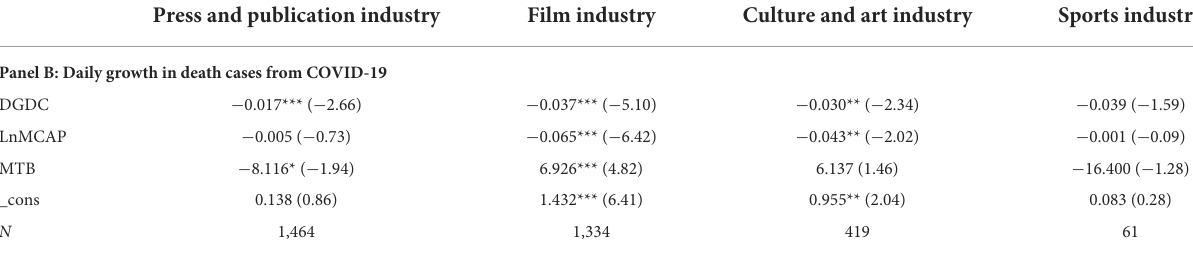
TABLE 5 Panel regression with specific sectors dummy variable. Press and publication industry